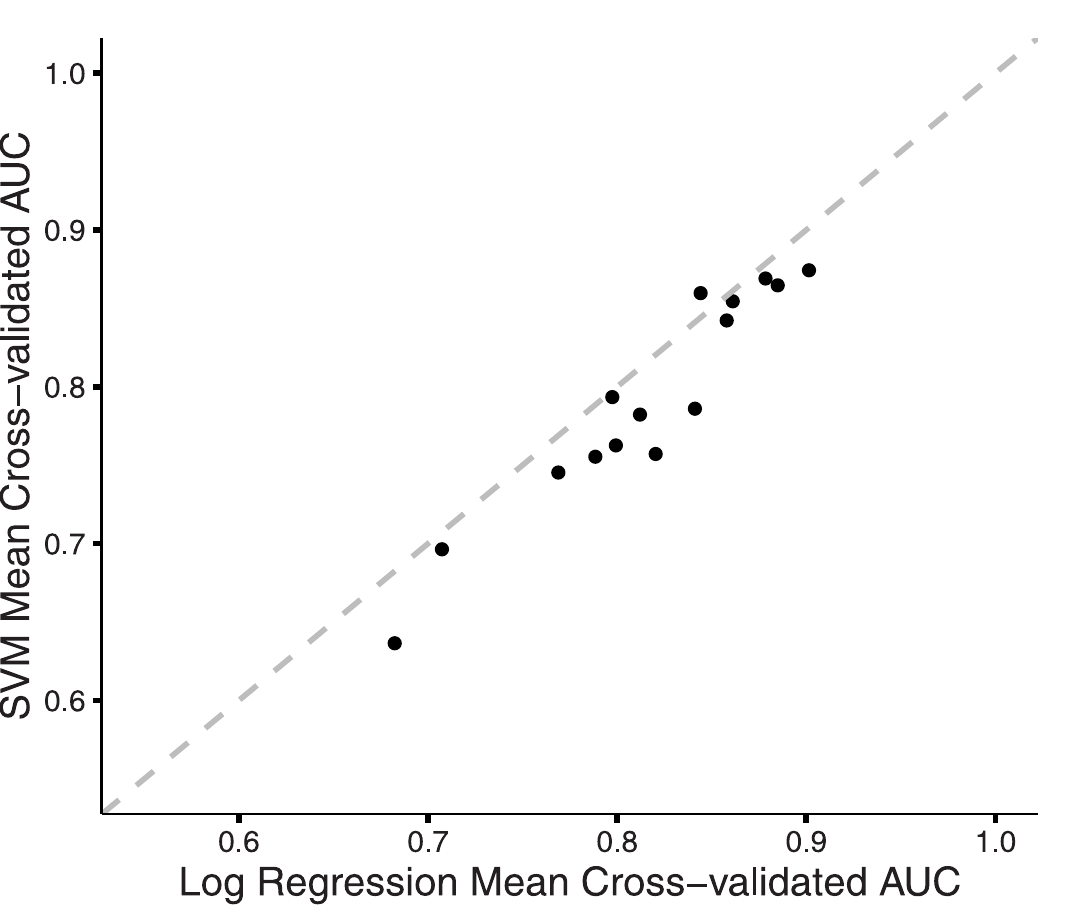
Fig 4. Comparison of mean cross-validated AUC from SVM and logistic regression models. For each set of predictor variables, the mean cross-validatedAUC value from the corresponding SVM is plotted againstthe mean cross- validatedAUC value from the corresponding logistic regressionmodel. The dotted gray line representsthe line y = x . For all but one model, logistic regression models with the same predictors have highermean cross-validated AUC values.